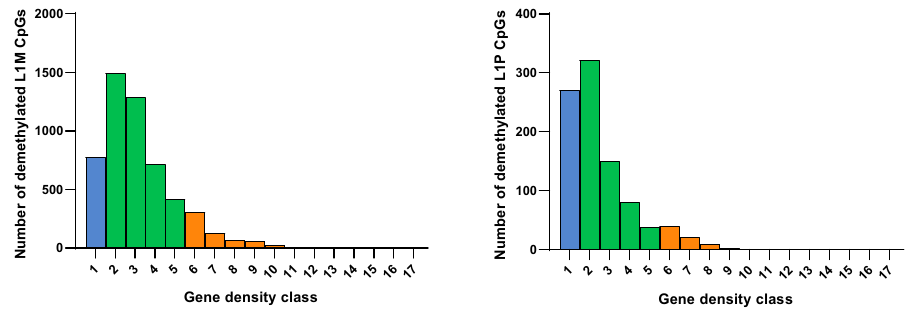
Figure 3. Distribution of significantly demethylated CpGs within LINE1 subfamilies L1M and L1P grouped according to gene density classes. Low gene density (class 1), blue; intermediate gene density (classes 2–5); green; high gene density (classes 6–17), orange.